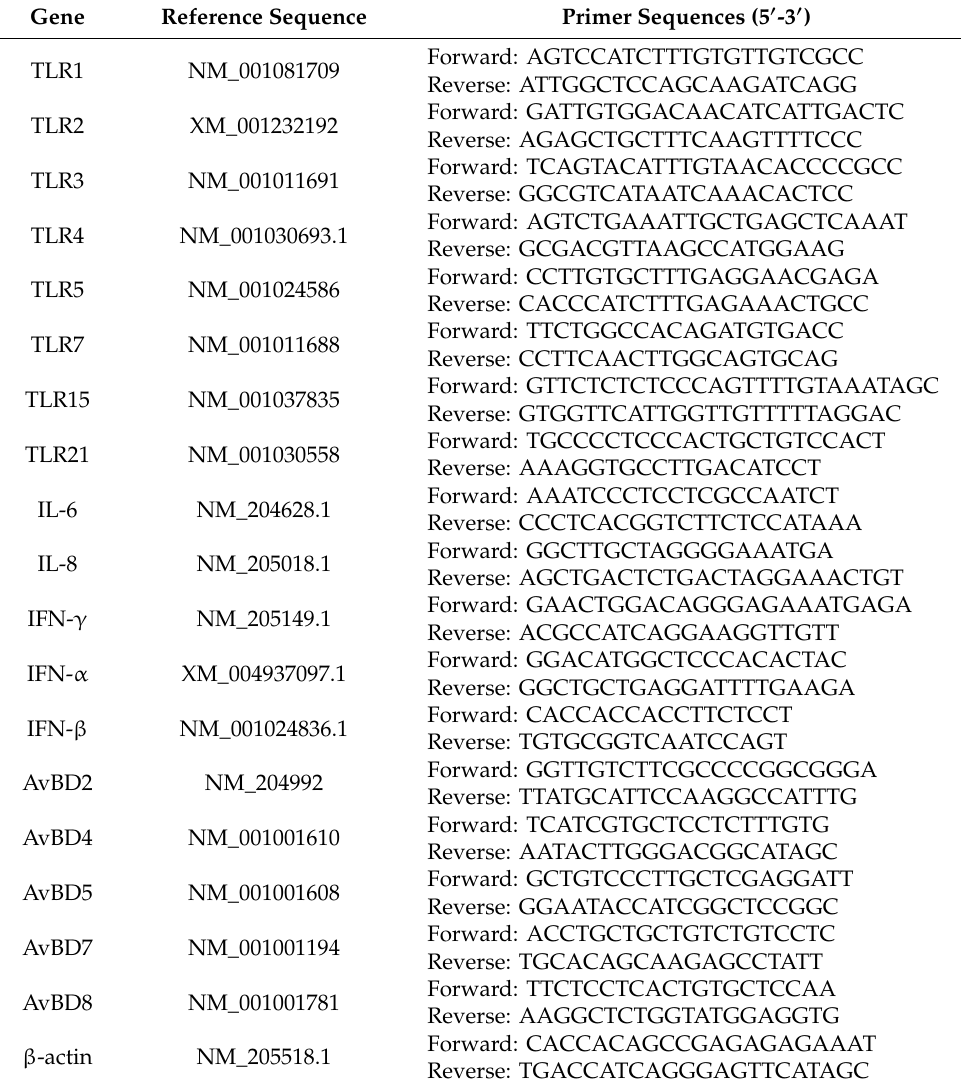
Table 1. Gene primer sequences used for qPCR